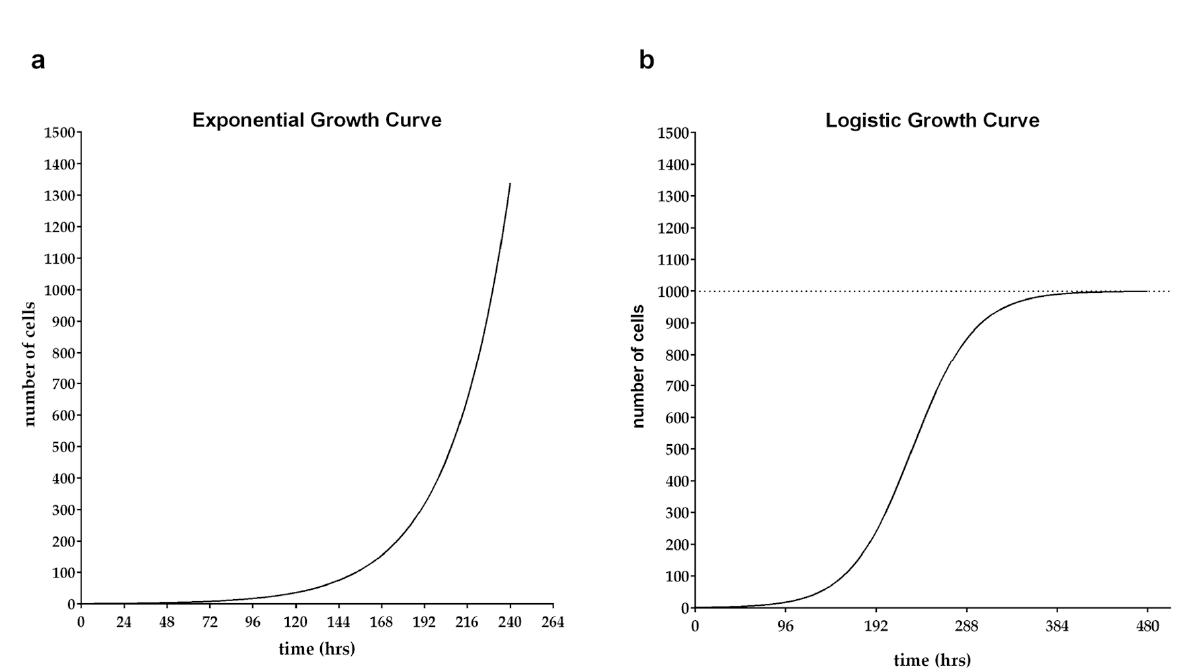
Figure 1. Models of the growth curves: ( a ) exponential growth curve; ( b ) logistic growth curve. ( a ) The exponential growth curve was modeled in GraphPad Prism 6 software (Dotmatics, Boston, MA, USA) using Plot a function analysis using the Exponential growth equation with the following parameters: P(0) = 1; k = 0.03 (k was derived from Equation (14) with the doubling time D equal to 24 h). ( b ) The logistic growth curve was modeled in GraphPad Prism 6 software (Dotmatics, Boston, MA, USA) using Plot a function analysis using the Logistic growth equation with the following parameters: P(0) = 1; k = 0.03 (k was derived from Equation (14) with the doubling time D equal to 24 h; K = 1000, where K is the maximum cell